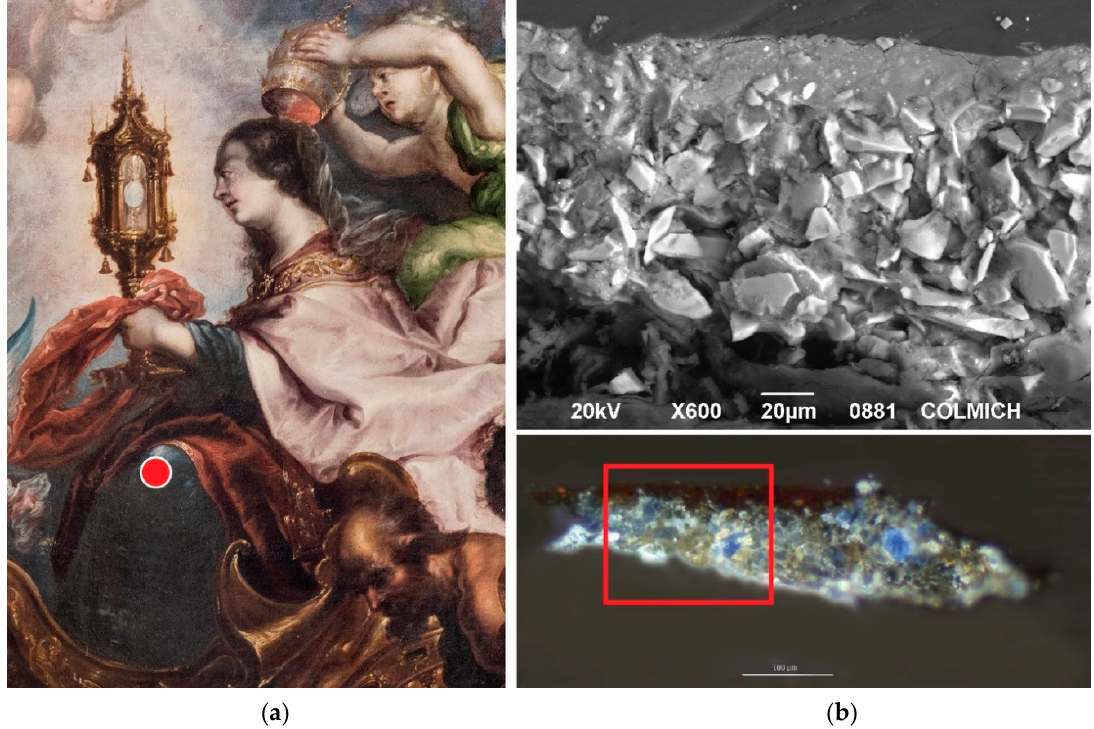
Figure 8. ( a ) Detail of the Church in El Triunfo de la Iglesia . The area where the sample was taken from is marked with a red dot. Detail of photograph by: Gerardo Hernández Rosales. Reproduction authorized by the Instituto Nacional de Antropología e Historia. ( b ) Cross-section under optical microscope (20×) ( bottom ) and SEM image (600×) ( top ). The area analyzed with SEM is marked with a red rectangle. Images by LADiPA-COLMICH.